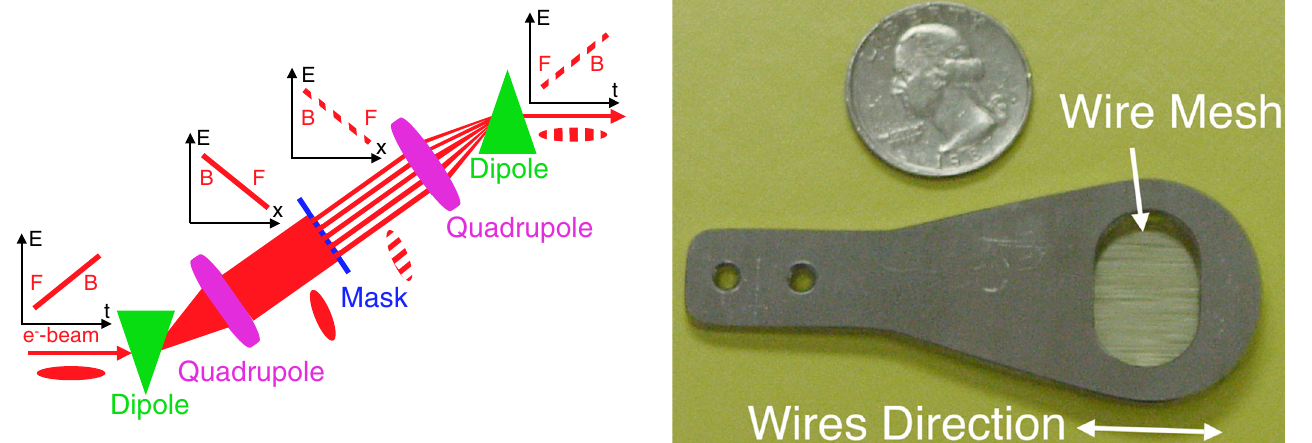
FIG. 2. (Color) Simplified schematic of the mask principle. Only the dogleg section of the beam line and two quadrupoles are pictured (not to scale). The side graphs represent the beam energy correlation with the beam front labeled by F and the back by B.